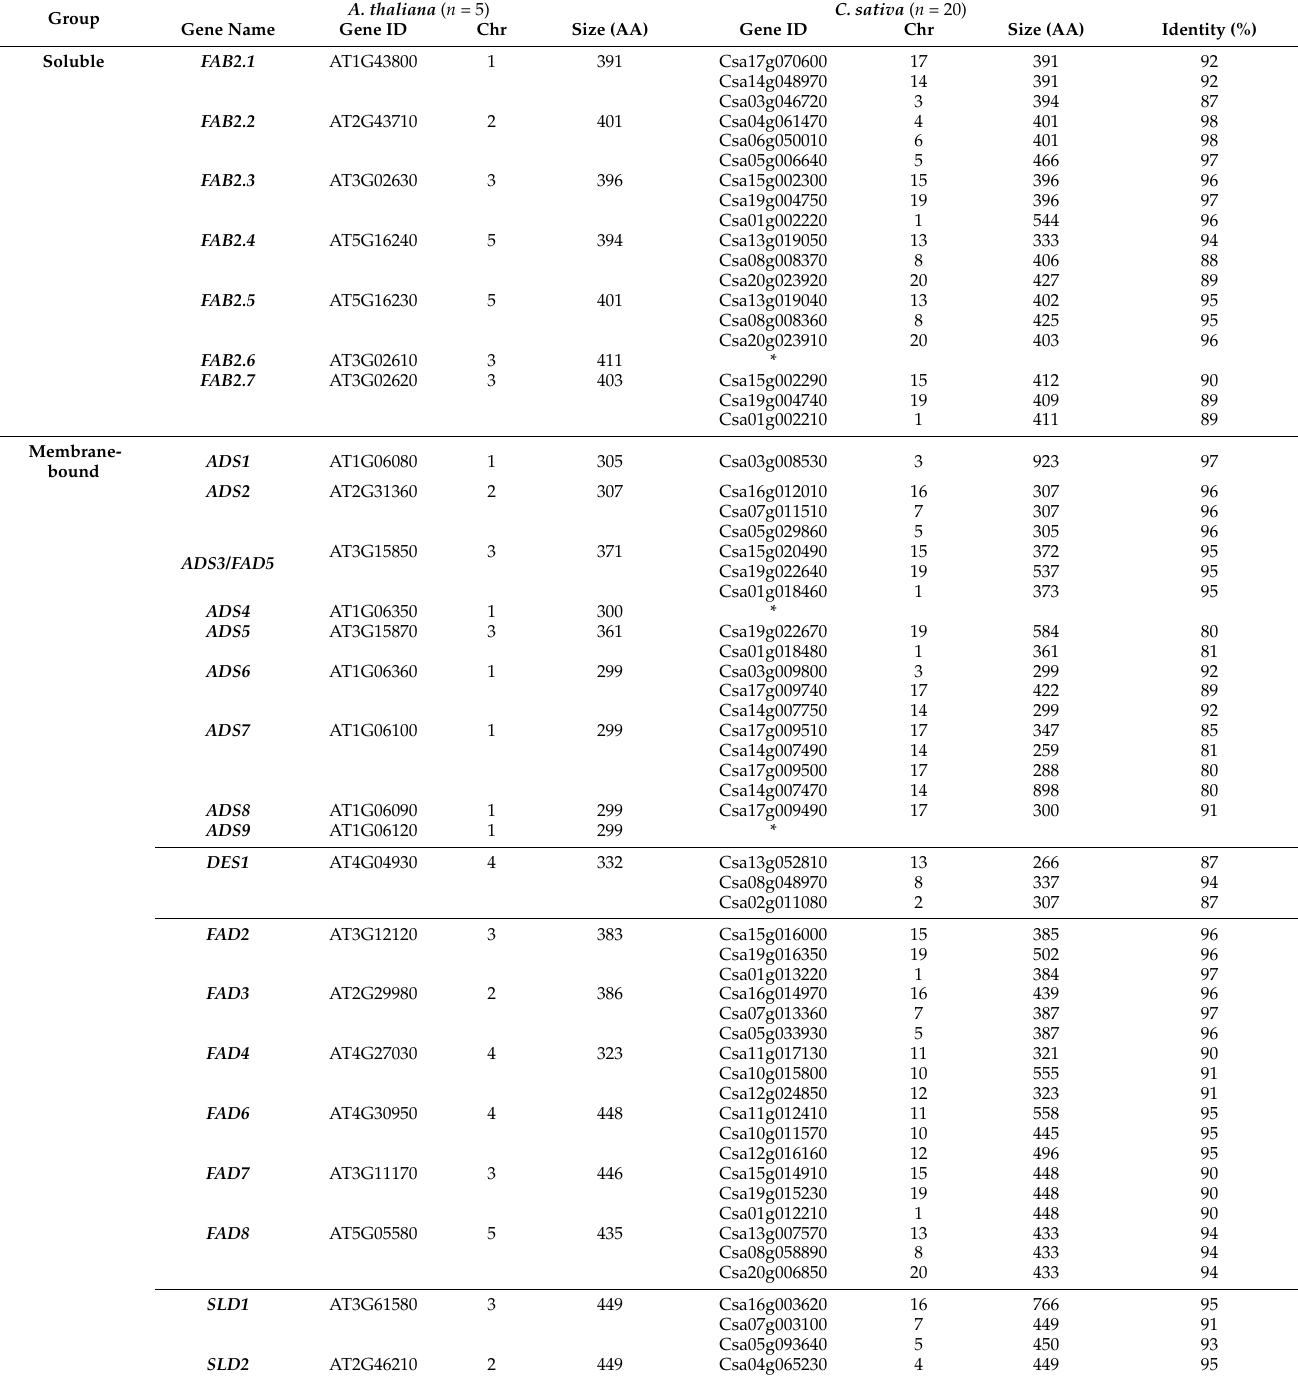
Table 1. List of FAD genes in A. thaliana and C. sativa